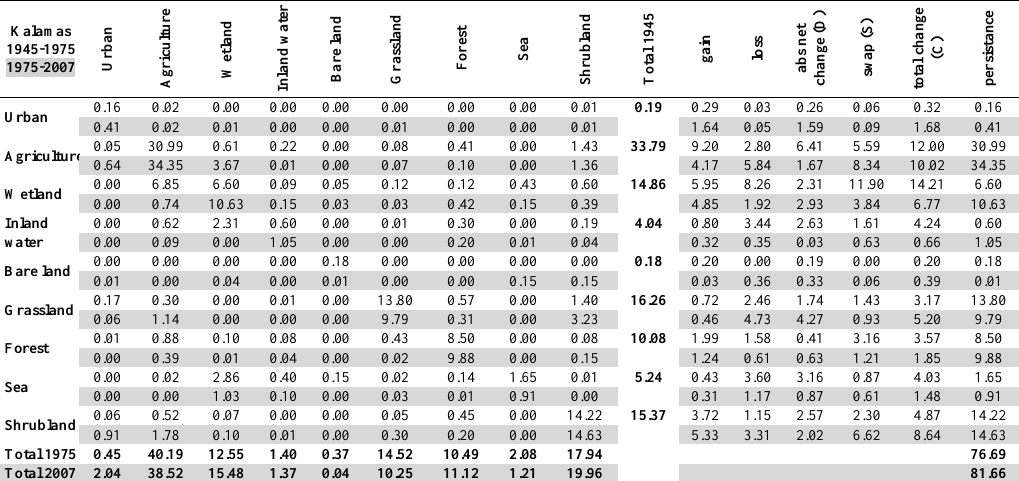
Figure 5. Deltaic area-based principle outputs: LULC thematic maps, changes, LULC composition, selectivity of changes, landscape metrics, and transition matrices. The example of Kalamas Delta is shown here. Data for all the deltas studied are presented in the Supplementary Material.